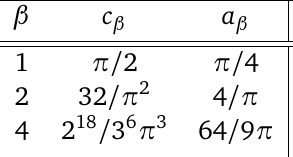
Table 1: The constants c β and a β for different